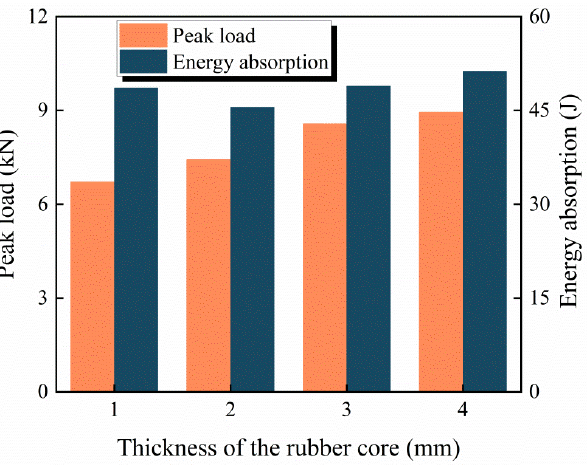
Figure 13. Peak load and impact energy absorption with different rubber core thicknesses.